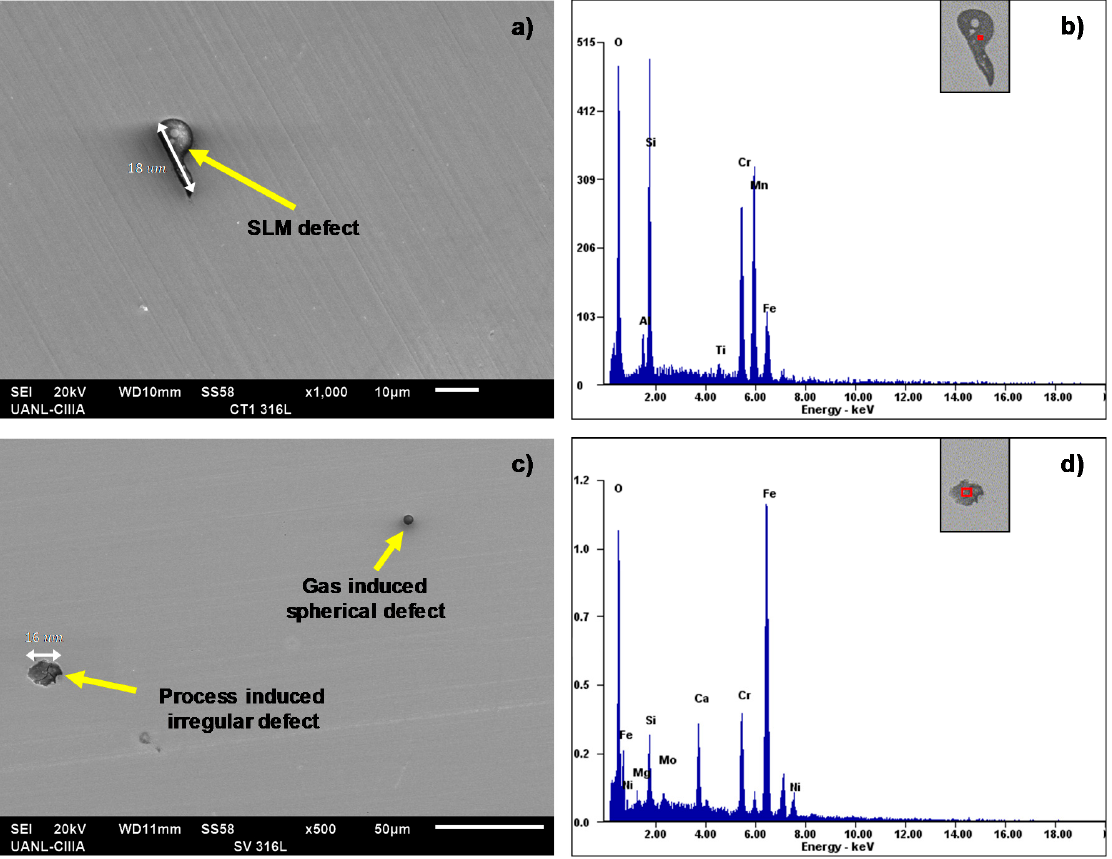
Figure 5. SEM images of the polished surfaces of the samples displaying some SLM defects in the material (left-hand side) ( a , c ; 100X and 500X, respectively) and chemical composition obtained by EDS of those irregularities (right-hand side; b , d ).